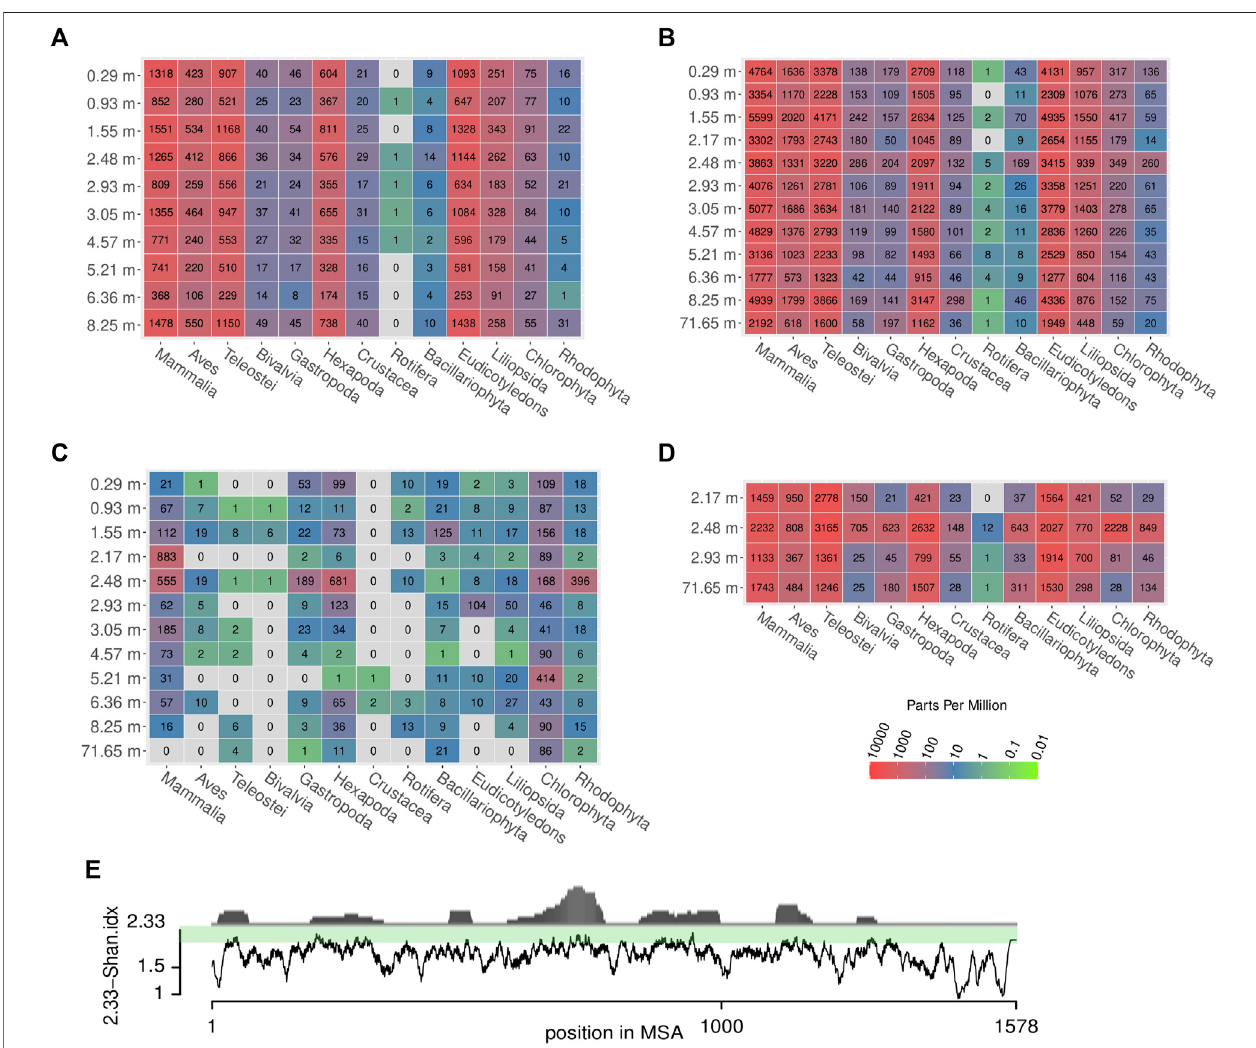
FIGURE9| Relativeandabsoluteabundancesofreadsassignedtodifferenteukaryotictaxaacrosssamplesandmethods.Colorsrepresentpartspermillion(ppm) of reads, grey: no reads. The absolute number of reads is written in the center of the colored tiles. (A) shotgun data, (B) fi rst round capture data, (C) fi rst round capture datamappedto cox1 sequencesoftherespectivetaxa, (D) secondroundcapturedata, (E) propensityofreadstomaptoparticularregionsinthe cox1 gene(distribution in upper part) and degree of sequence conservation (lower part), which is estimated by a moving average ( n (cid:1) 10) of its Shannon entropy per column. The